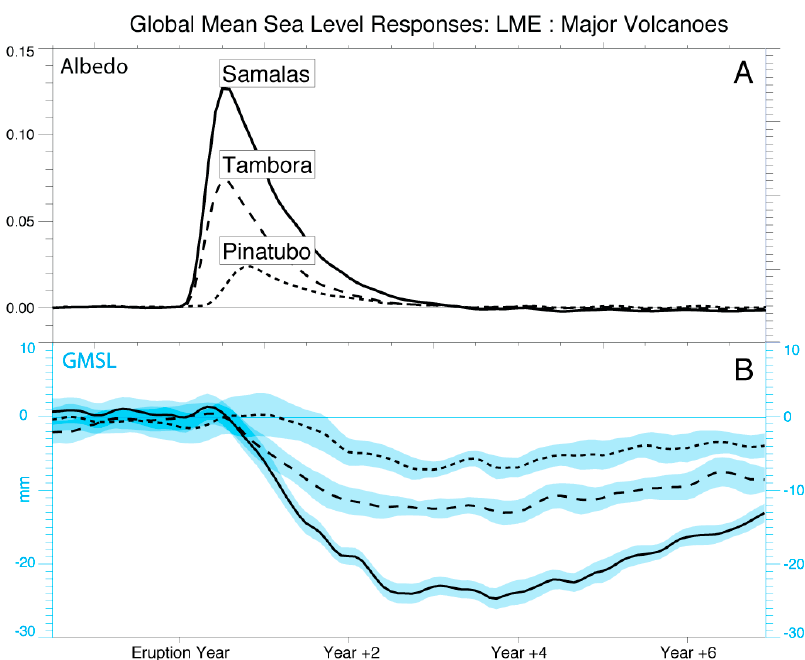
Figure 8. Anomalies in the LME associated with the eruptions of Mts. Pinatubo (dotted, June 1991), Tambora (dashed, April 1815), and Samalas (solid, assumed April 1257) in: ( A ) clear ‐ sky albedo over low latitude ocean (30 N–30 S); and ( B ) GMSL. Shading in ( B ) indicates the σ range across ensemble members. Pinatubo’s lagged response is due to its later eruption date.